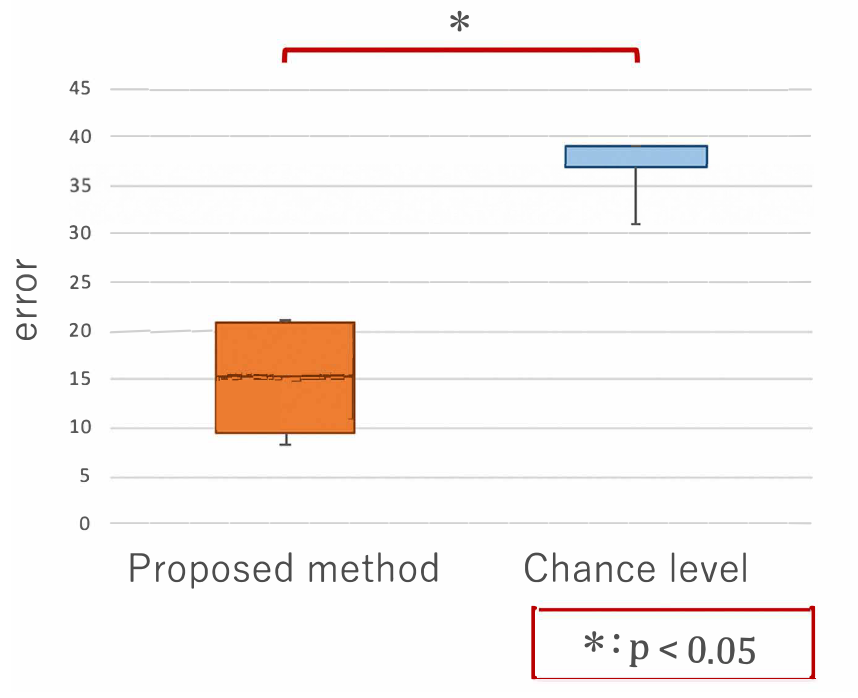
Figure 9. Comparison of errors between the proposed method and the chance